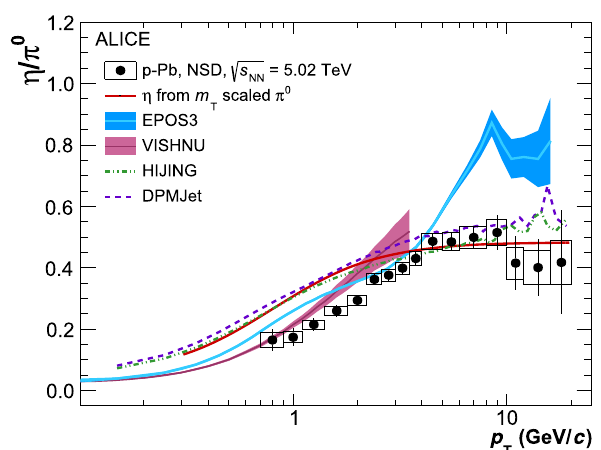
Fig. 10 Comparison of different theoretical calculations to the η / π 0 ratio measured in NSD p–Pb collisions at − 1 . 365 < y cms < 0 . 435 at √ s NN = 5.02 TeV from Fig. 7. Theoretical calculations are shown for the EPOS3 model [26] with statistical errors shown as a band, hydrody- namic framework (VISHNU) [98] using the iEBE-VISHNU code [99], DPMJET model [82] and HIJING model [81]